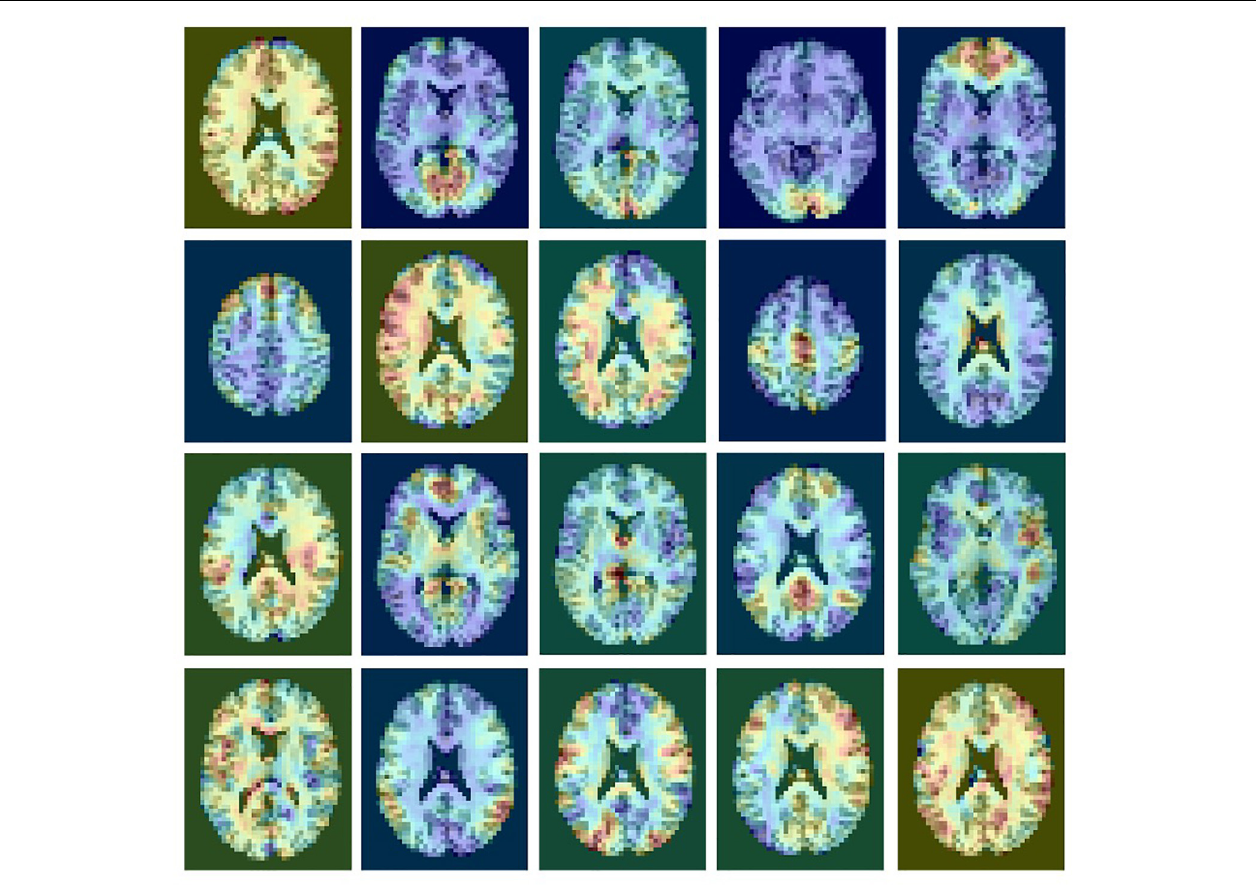
FIGURE 1 | An example of a single subject ICA decomposition with 20 outputs showing rsfMRI signals and noise components. ICA does not provide any labeling of the